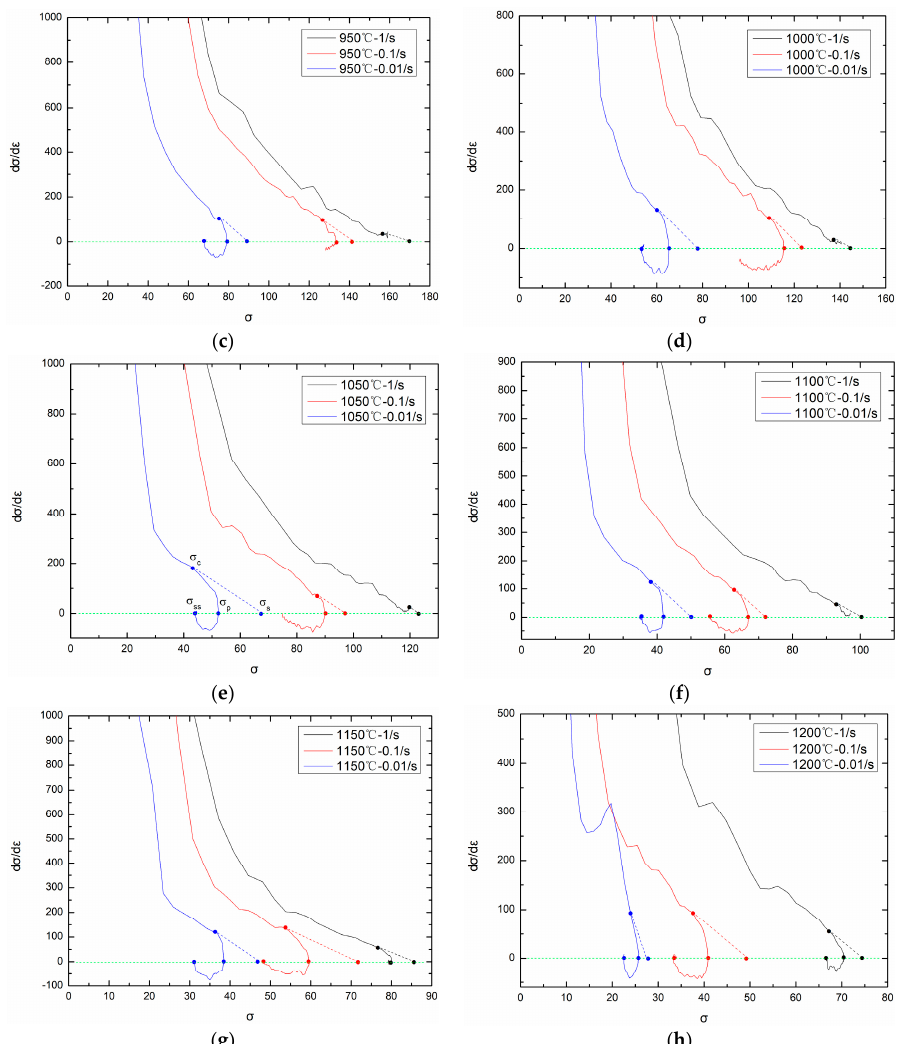
Figure 8. d σ /d ε - σ curves on different temperatures: ( a ) 850 °C; ( b ) 900 °C; ( c ) 950 °C; ( d ) 1000 °C; ( e ) 1050 °C; ( f ) 1100 °C; ( g ) 1150 °C; ( h ) 1200 °C.